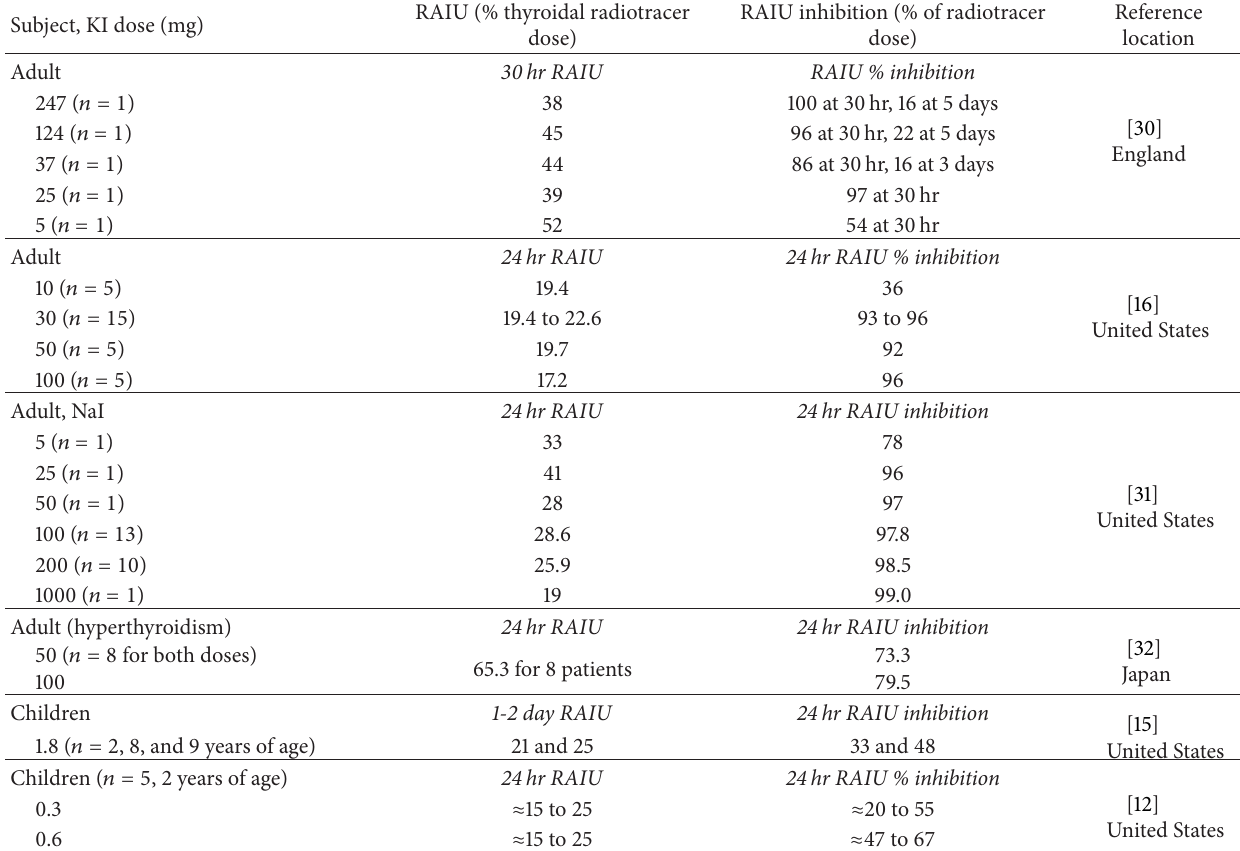
Table 5: Inhibition of radioactive iodide uptake (RAIU) into the thyroid gland by potassium or sodium iodide in children and adults. Subject, KI dose (mg)